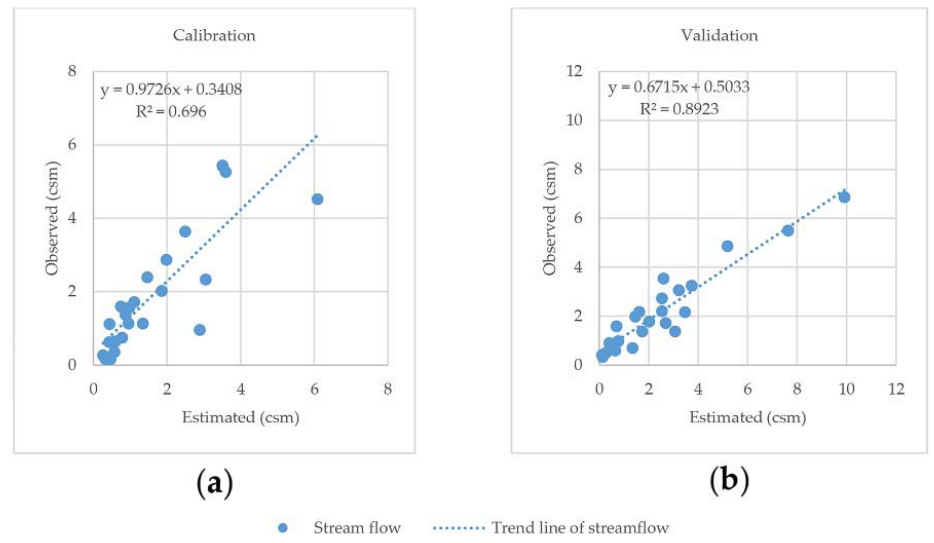
Figure 11. Scatter plot between observed and estimated streamflow at Khlong Bang Yai watershed under the wet year condition: ( a ) calibration period; ( b ) validation period.